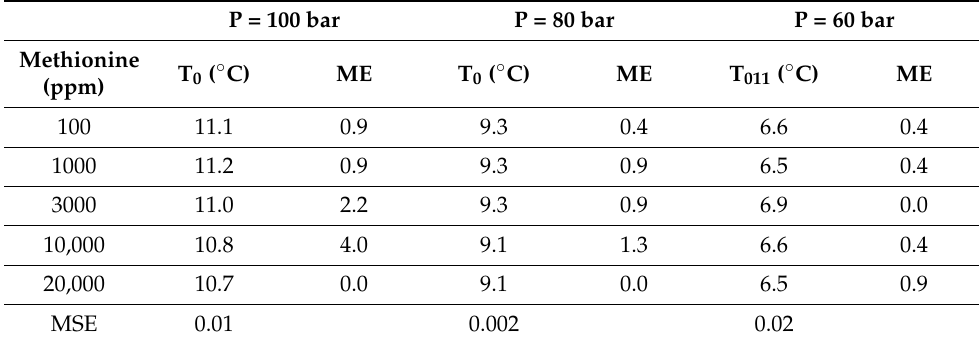
Table A3. Onset nucleation temperature T 0 ( ◦ C) (average) and ME for L-methionine at different concentrations. (100 ppm to 20,000 ppm).